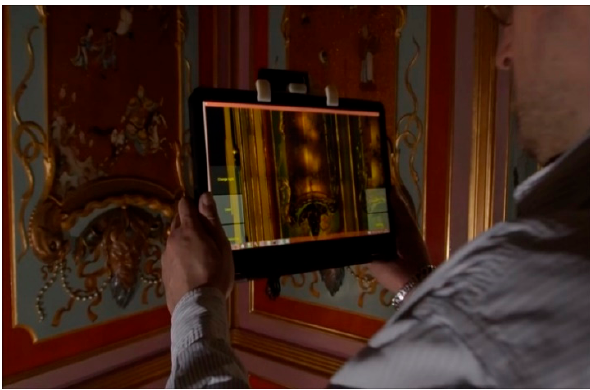
Figure 3. CATCHA-based application in use.